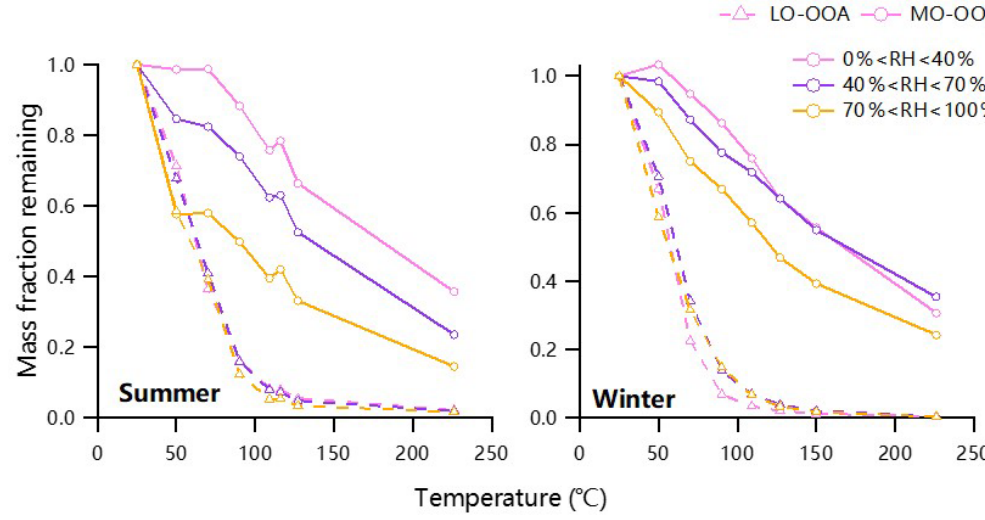
Figure 5. Thermograms of LO-OOA and MO-OOA during different RH levels in summer and winter in Beijing.